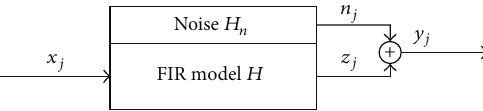
Figure 9: Diagram of the dynamic error analysis